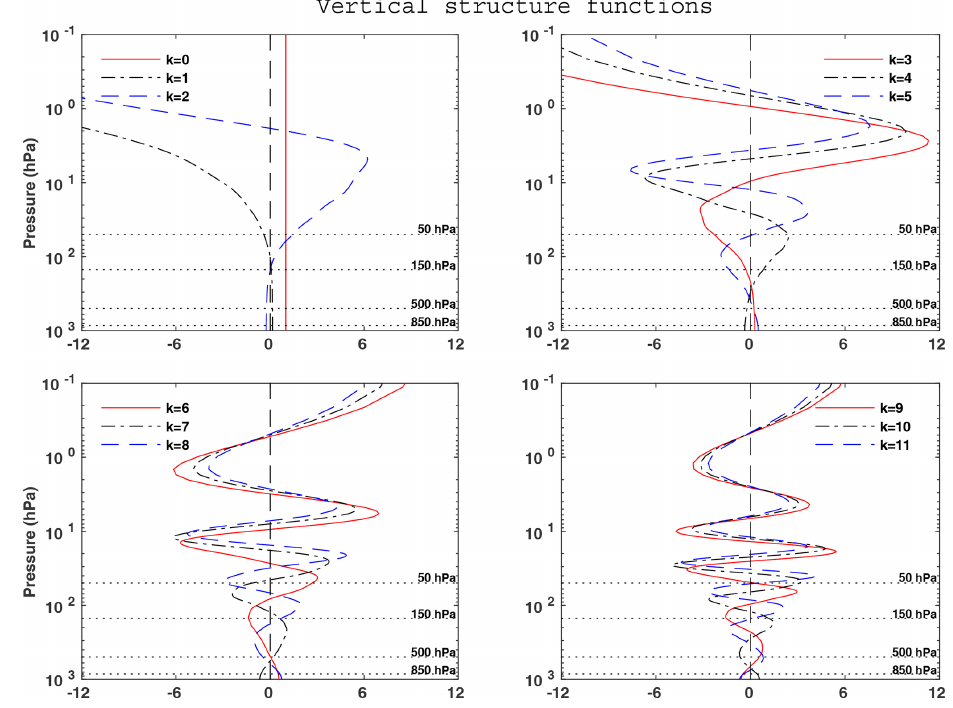
Figure 3. The first 12 vertical structure functions derived using T 0 and S 0 of Fig. 1 with boundary conditions (16) and